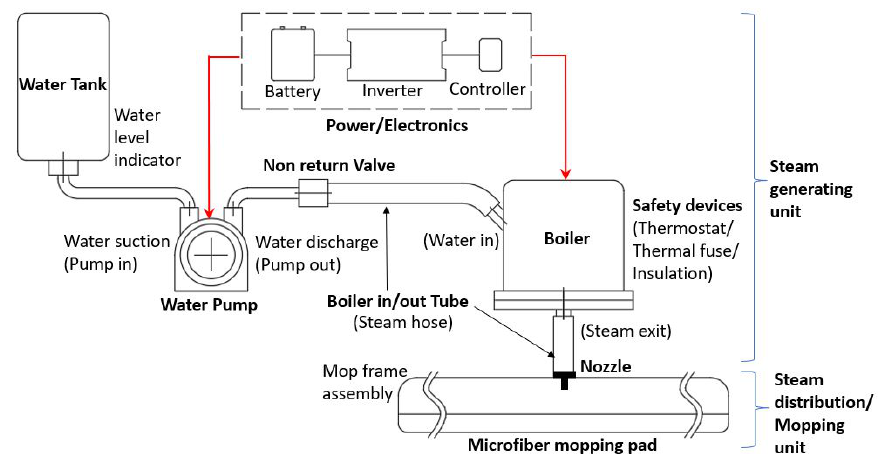
Figure 3. Steam generation and distribution process flow diagram.